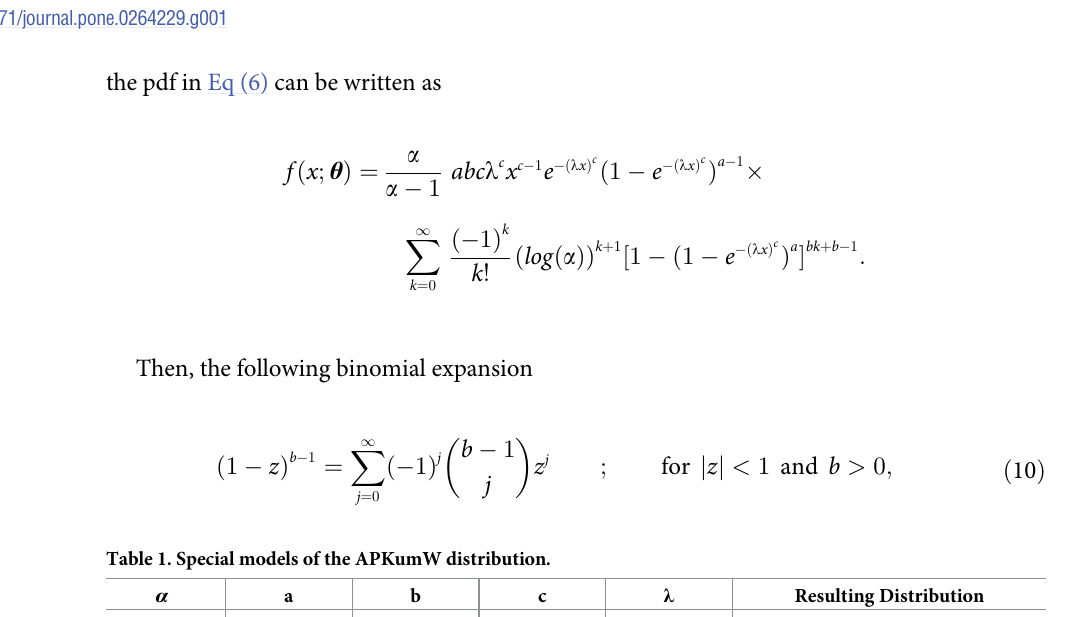
Fig 1. The APKumW pdf and hazard function for various values of its parameters.